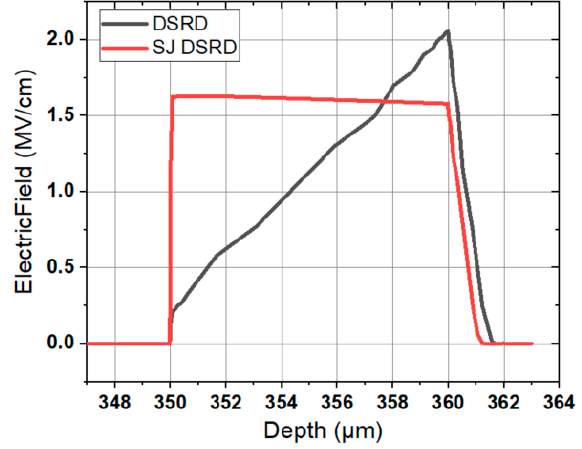
Figure 2. Electric field distributions in drift layer of conventional SiC DSRD and SJ SiC DSRD. ( T nb of 10 μ m, N nb of 1 × 10 16 cm − 3 ).